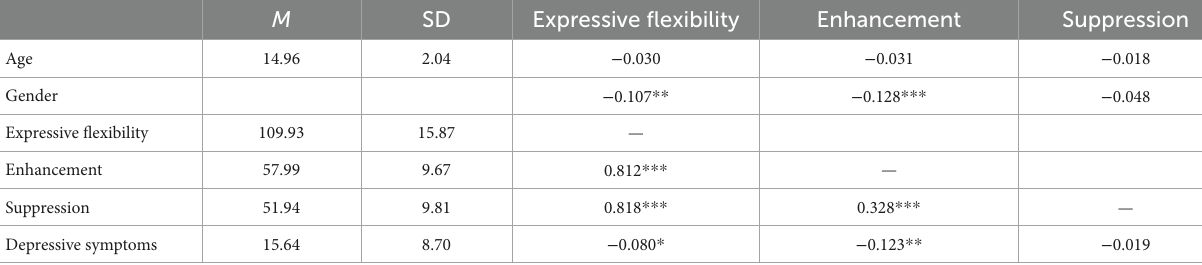
TABLE 1 Means, standard deviations and correlations for all the main variables.